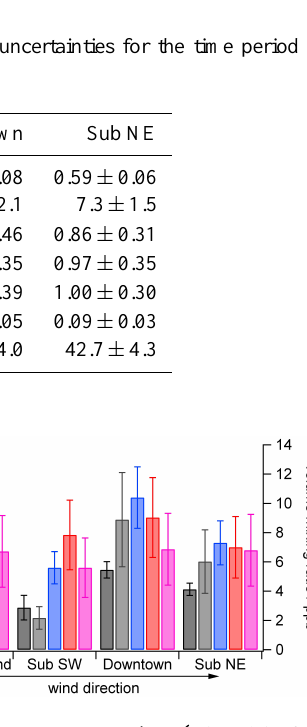
Fig. 11. Average mass concentrations (BC, HOA, SO 4 , OOA) and volume mixing ratios (NO x ) measured at the three stationary sites and at a background location (see Fig. 1) during the background measurement case study (15 July, 14:30 to 20:32; “Atlantic Clean” air masses). Error bars represent the associated estimated uncertain- ties for intercomparison purposes (see Sect. 2). The arrow indicates the wind direction of the connected flow during the measurement period. The exact values and additional data from NO 3 and O 3 are given in Table